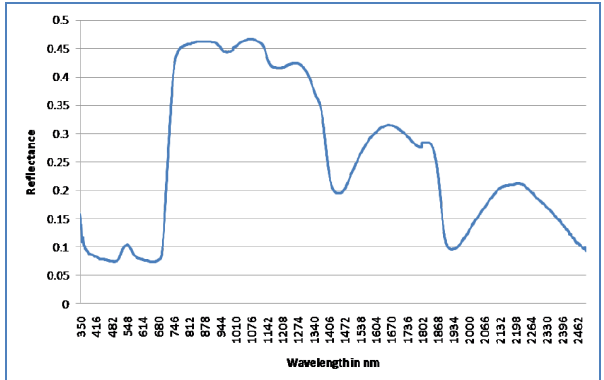
Figure 1: Typical green vegetation